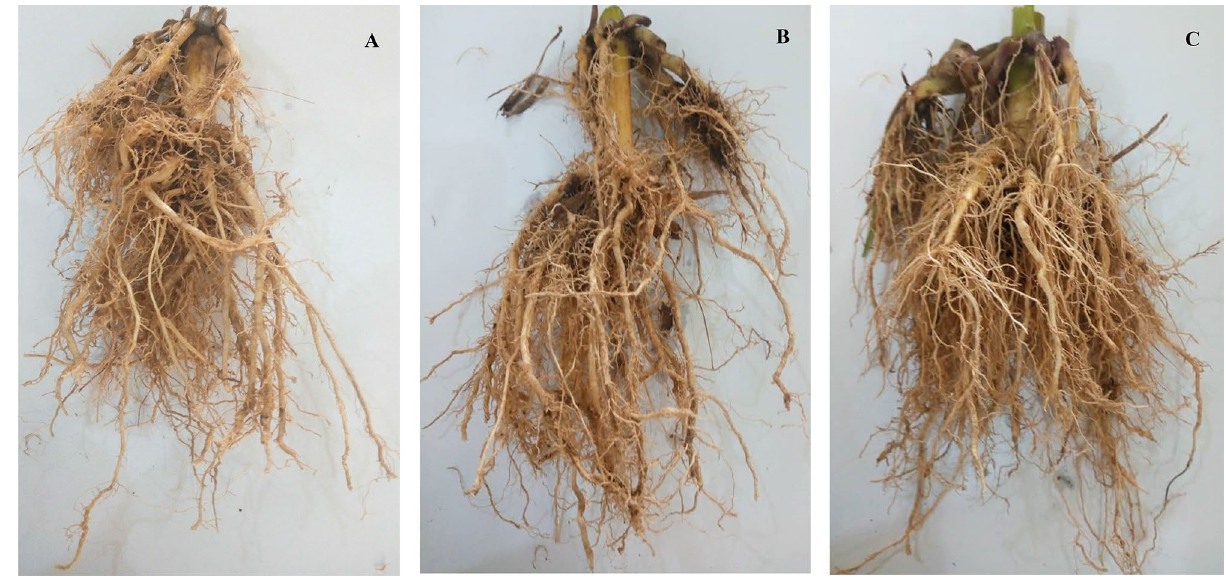
Figure 3. Complete root system from ( A ) the control (No fertilizer application) experiment ( B ) the NPK fertilized experiment ( C ) organic fertilized experiments (30 kg